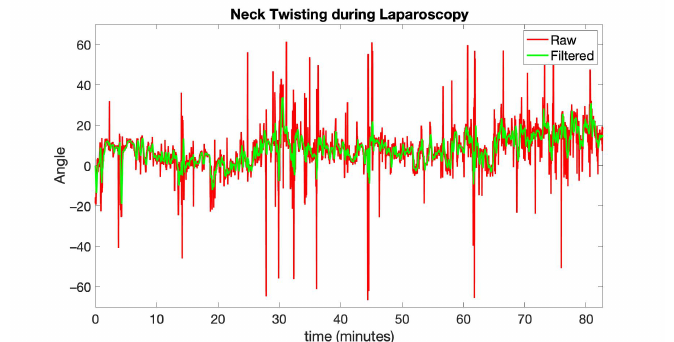
Figure 7. Raw and filtered signal related to neck twisting during